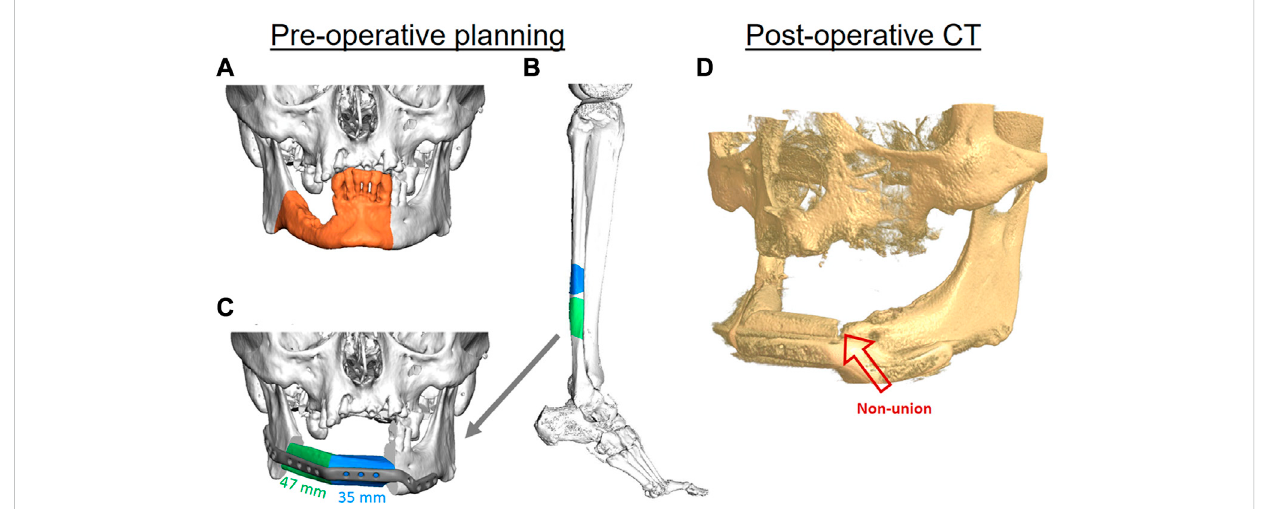
FIGURE 1 The virtual planning steps for mandibular reconstruction. Three-dimensional (3D) reconstruction of a cone beam computed tomography (CBC) scan, showing the area of affected bone including a safety margin of the right-sided mandible (orange area) (A) . A two-segmental fi bula free fl ap (FFF) from the right leg (green and blue parts) was virtually planned for the reconstruction of the mandibular defect using computed tomography (CT) (B) . The segments were virtually fi tted, and fi xation was planned using a patient-speci fi c 3D-printed titanium reconstruction plate (C) . The postoperative CBCT scan of the patient after 11 months demonstrates a non-union between the FFF and the mandible in the anterior region (red arrow) (D)